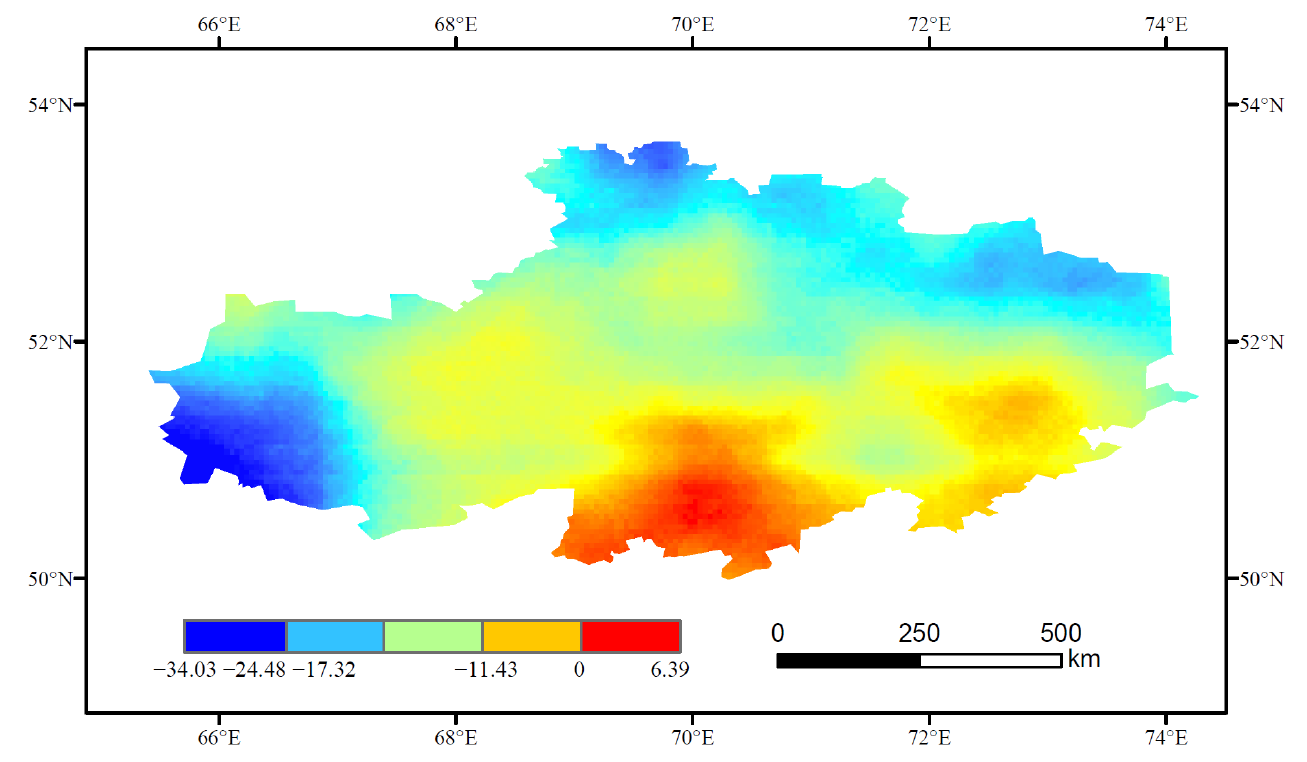
Remote Sens. 2022 , 14 , x FOR PEER REVIEW